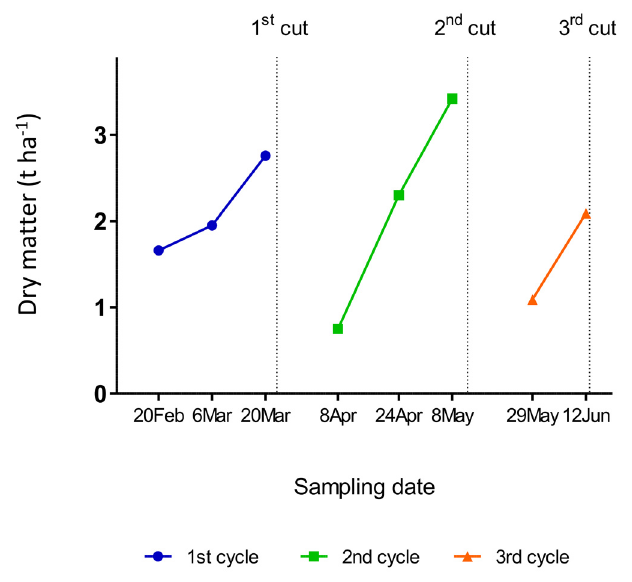
Figure 4. Forage productivity throughout the crop growing